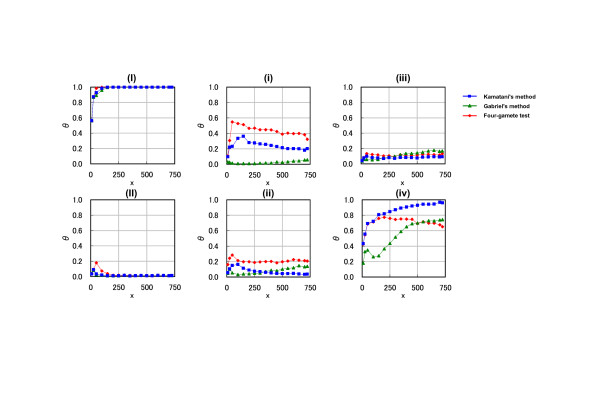
The effect of sample size on haplotype block characteristics under different block definitions: θ profiles versus sample number (x). The number of repeat times (n) was adjusted to 3,000 (N = 3,000). The labels of analyzed SNPs intervals are identical to those in Figure 1. Sample size (x) is shown on the horizontal axis. θ profiles (ratio of times to N times when simulating the transition zone of haplotype block) are shown on the vertical axis. The three labels represent different haplotype block definitions: blue square, Kamatani's method; green triangle, Gabriel's method; red diamond, four-gamete test.